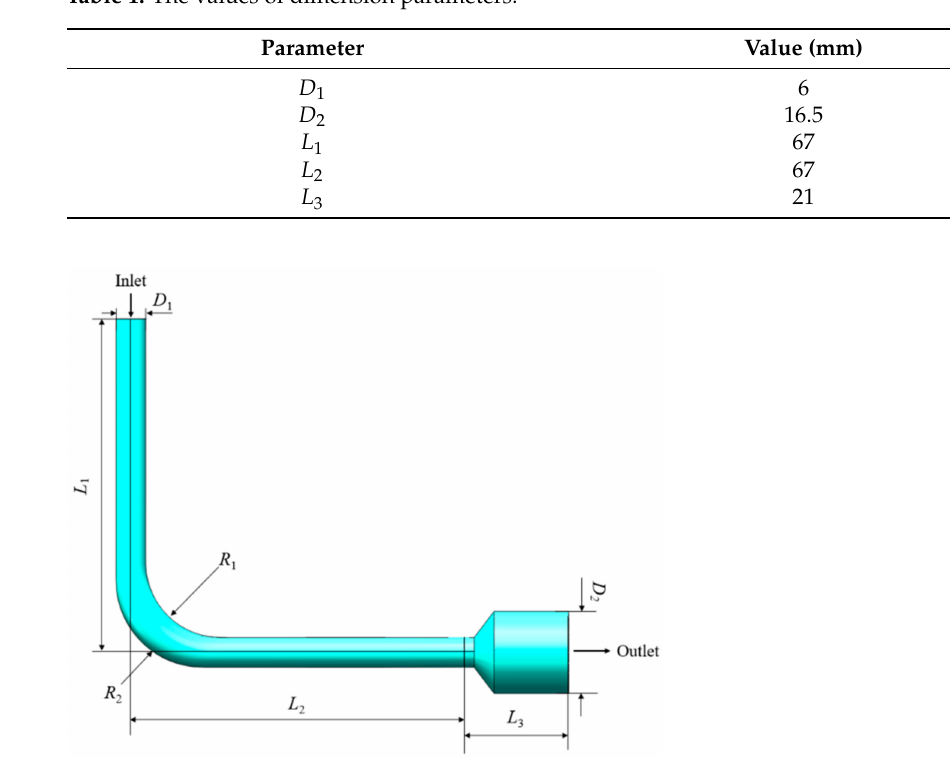
Table 1. The values of dimension parameters.